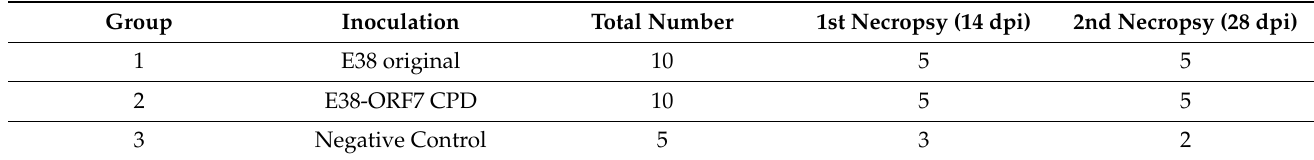
Table 1. Attenuation of virulence by CPD.